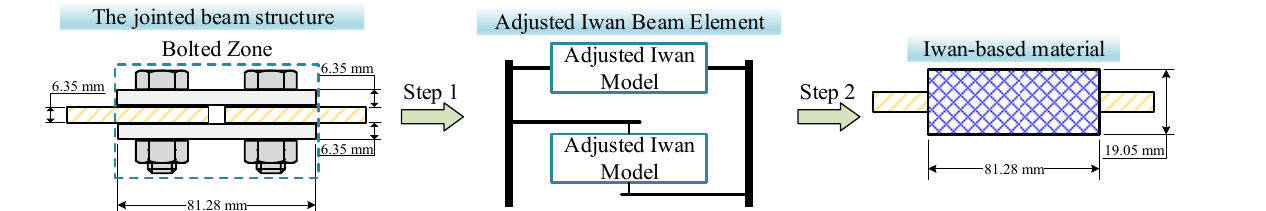
Figure 4. Equivalent method of the bolted connection. Step 1: replace the bolted zone with the adjusted Iwan model; Step 2: the adjusted Iwan model is equivalent to a regular hexahedron using the Iwan-based material.